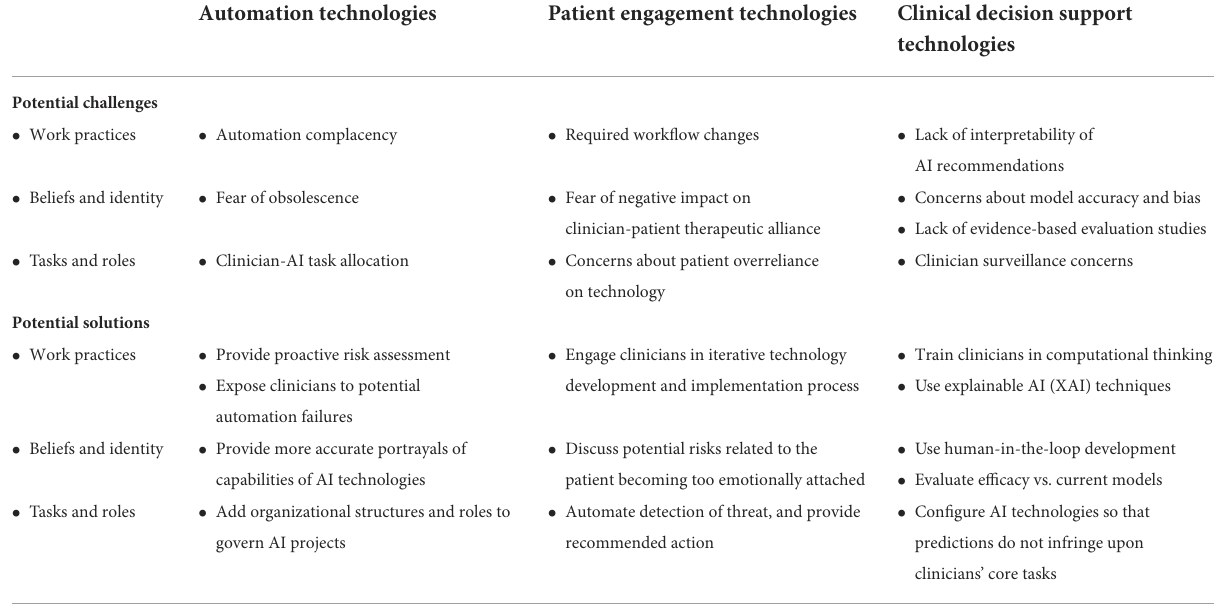
TABLE 2 Challenges and potential solutions related to pragmatic